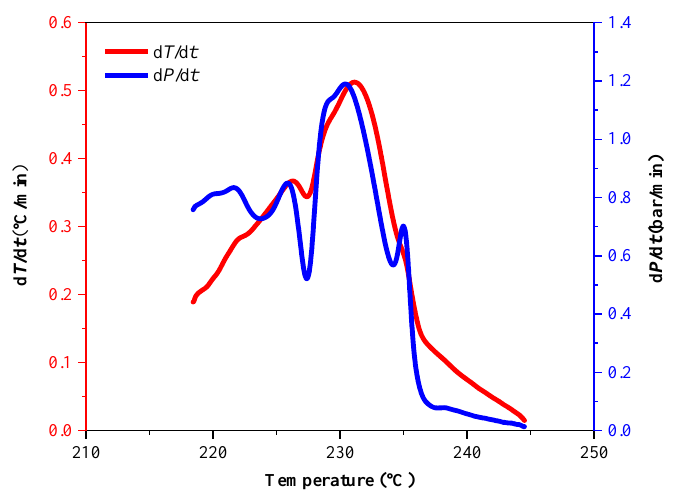
Figure 6. Temperature rise rate and pressure rise rate versus temperature curves of LP30 + PFPN.